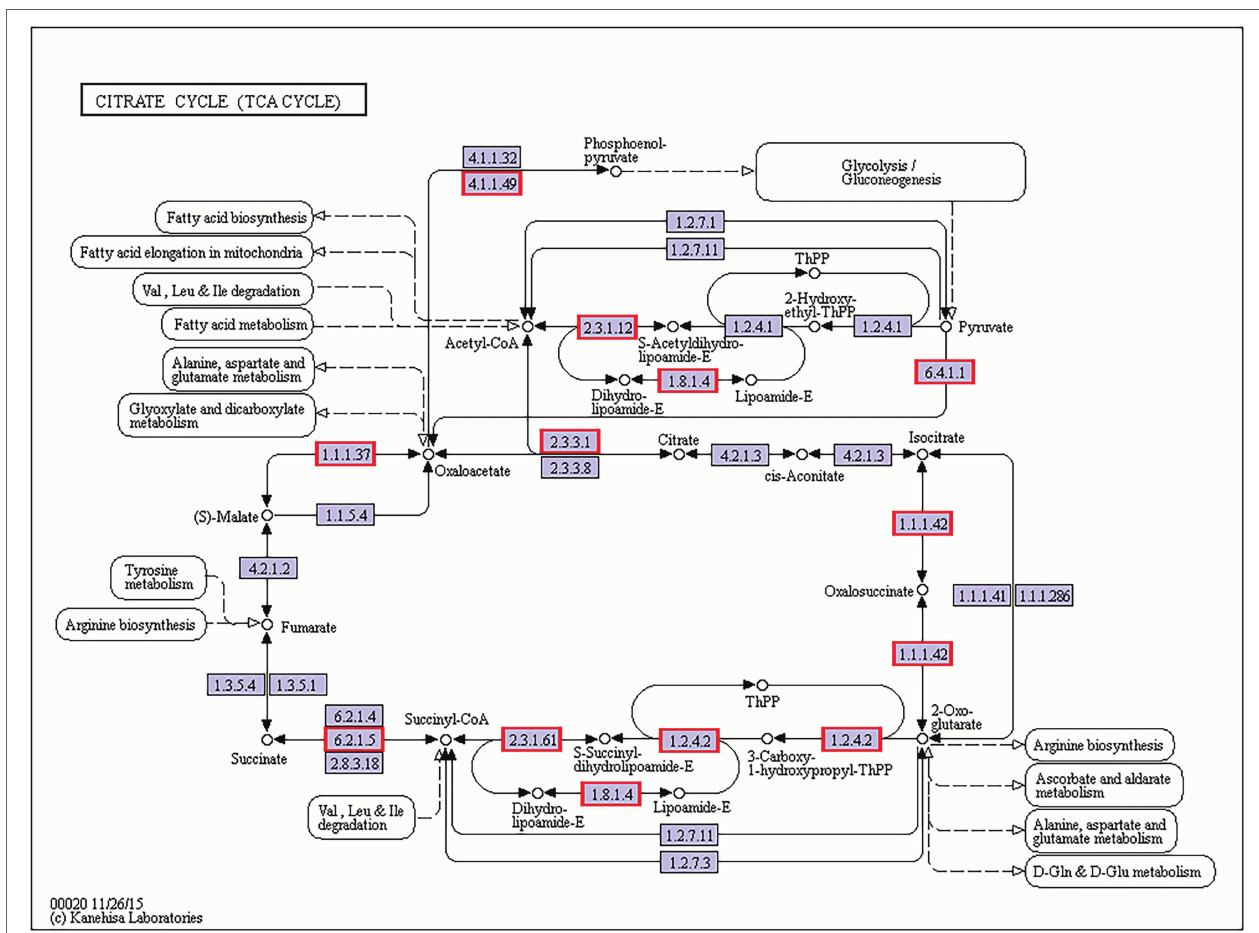
FIGURE 9 | B. amyloliquefaciens differentially expressed genes (DEGs) in citrate cycle (ko00020) KEGG pathway. The genes with red/blue border in the figure were DEGs identified by dual RNA sequencing analysis, where red represents up-regulated genes and blue represents down-regulated